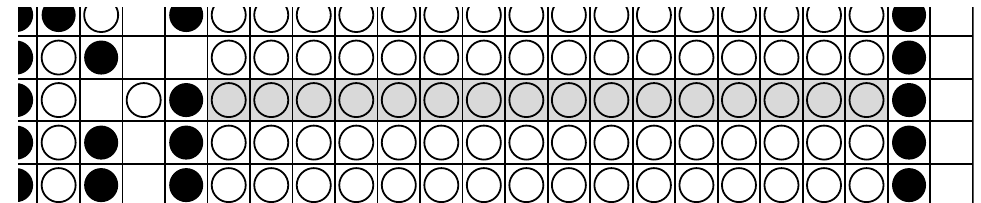
Figure 39. BLACK